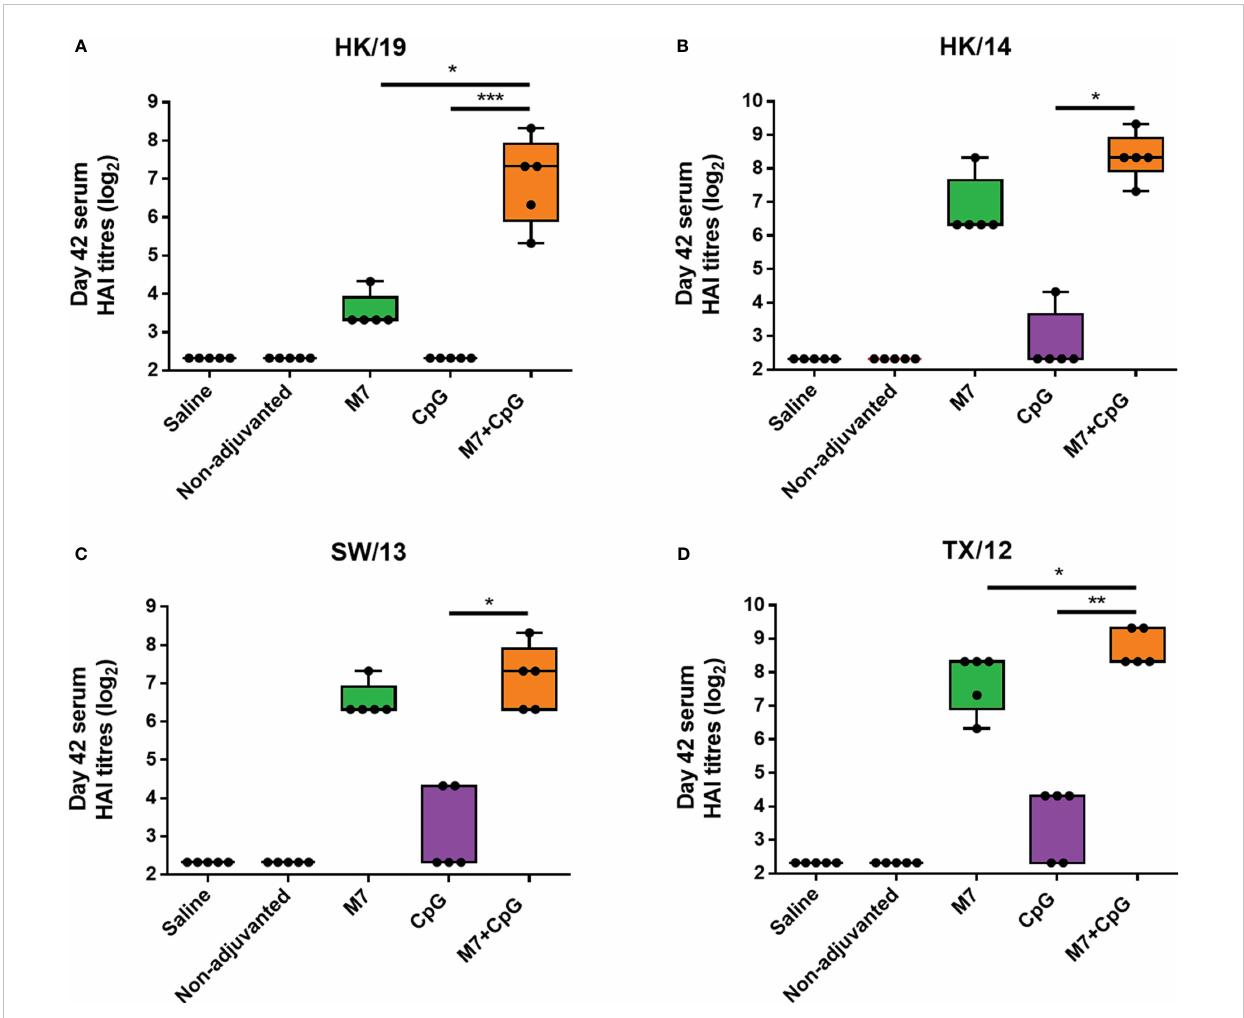
FIGURE 6 The M7-CpG NPs adjuvanted COBRA vaccine induced a broad HAI antibody response against in fl uenza viruses. C57BL/6 mice were intranasally immunized with experimental groups on days 0, 21, and 35 and sera were collected on day 42. Day 42 sera from the different mouse groups were evaluated for HAI titers against the H3 in fl uenza viruses (A) A/Hong Kong/2671/2019 (HK/19), (B) A/Hong Kong/4801/2014 (HK/14), (C) A/ Switzerland/9715293/2013 (SW/13), and (D) A/Texas/50/2012 (TX/12). Data are presented as mean ± range ( n = 5) (representative plots of two independent experiments). Signi fi cant differences were determined using a one-way ANOVA test with Tukey ’ s multiple comparison on the data shown (* p ≤ 0.05; ** p ≤ 0.01; *** p ≤